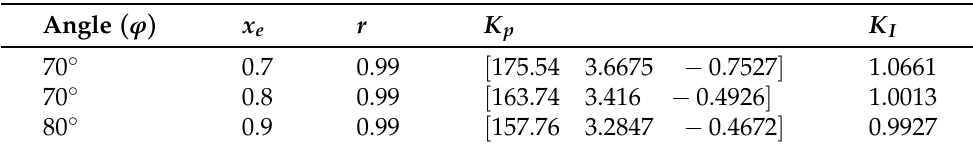
Table 6. Parameters of LMI pole placement controllers designed for various damping angle (Angle- Ellipse